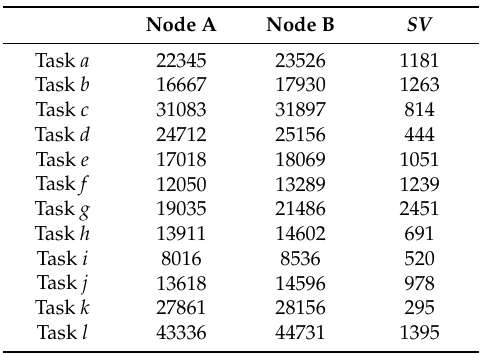
Table 5. Calculation of the SV values of tasks.